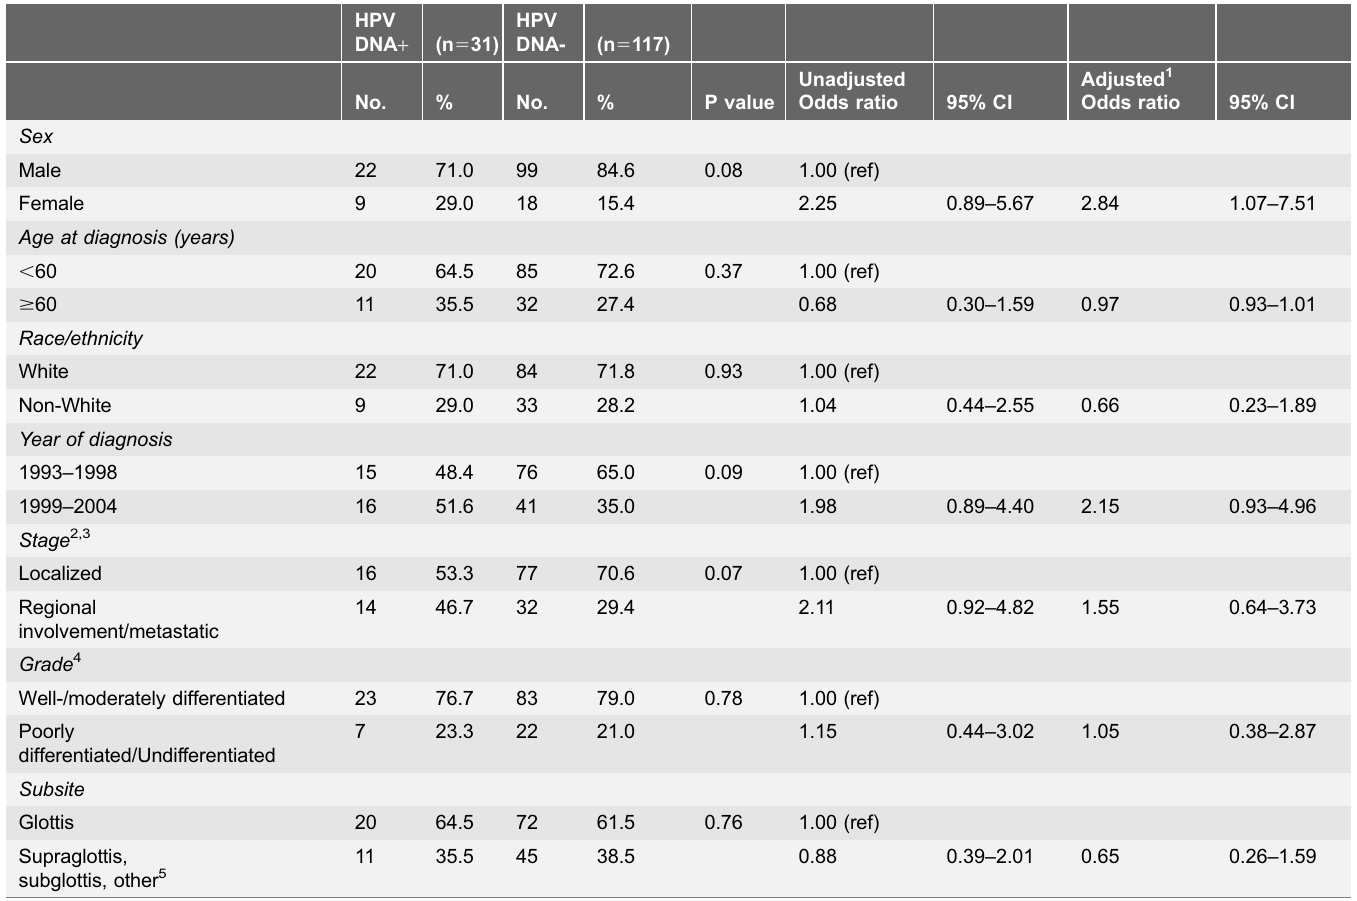
Table 2. Relationship of HPV and laryngeal cancer case